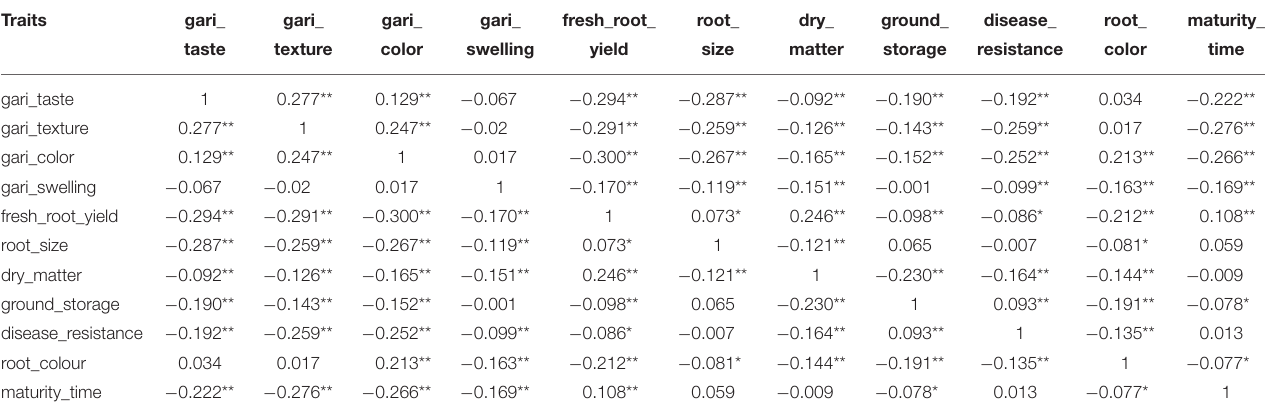
TABLE 1A | Pearson correlations among cassava traits.